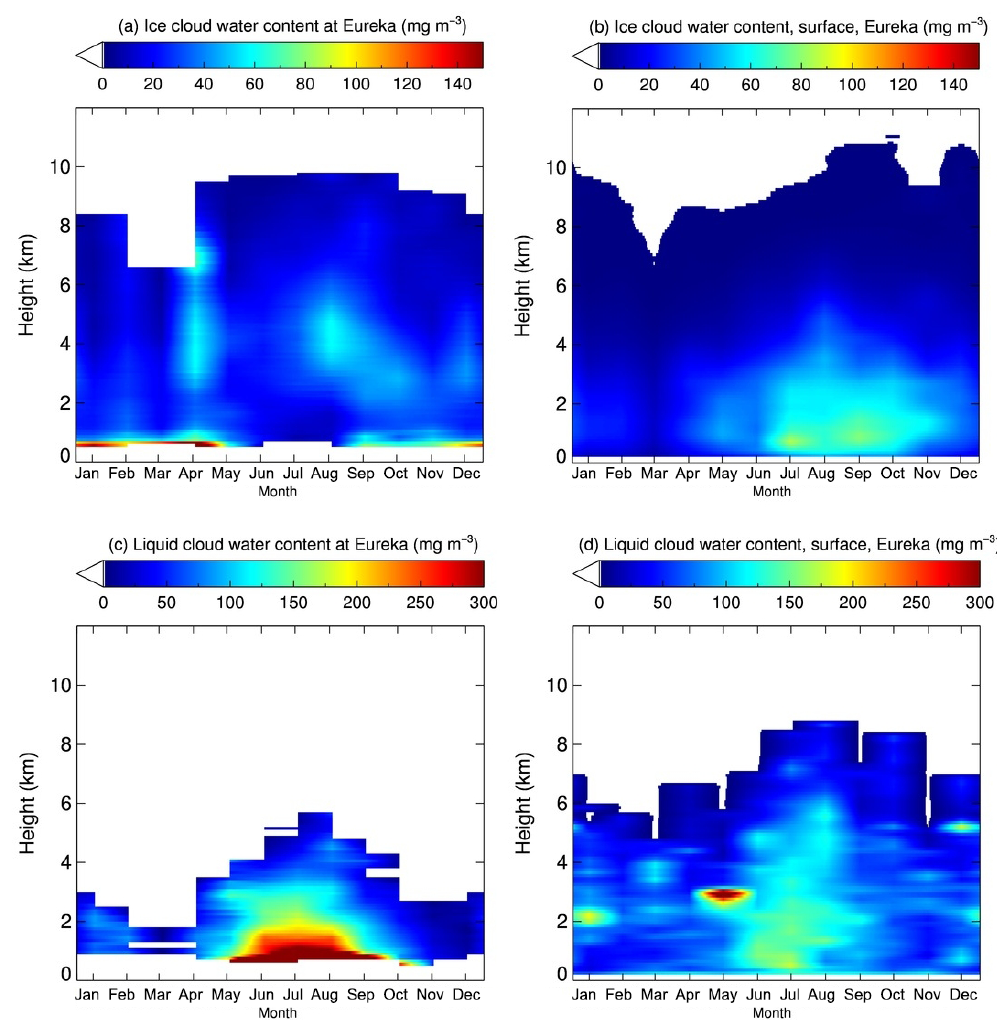
Figure 13. The same as Fig. 12 but for